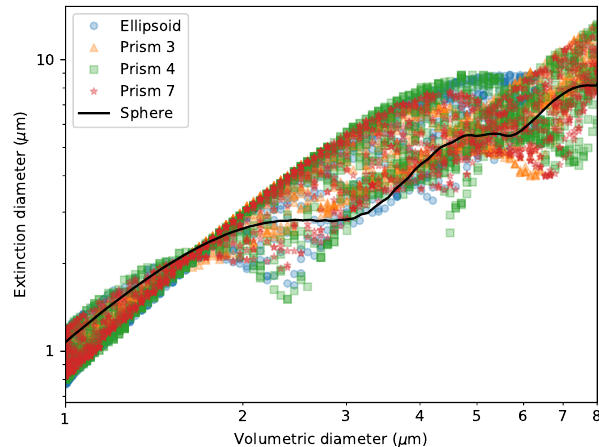
Figure 3. ADDA simulations of particles with a refractive index of 1.586 and, except for the spheres, an aspect ratio of 0.3. The prisms are oblate and their cross sections are equilateral polygons with 3, 4 and 7